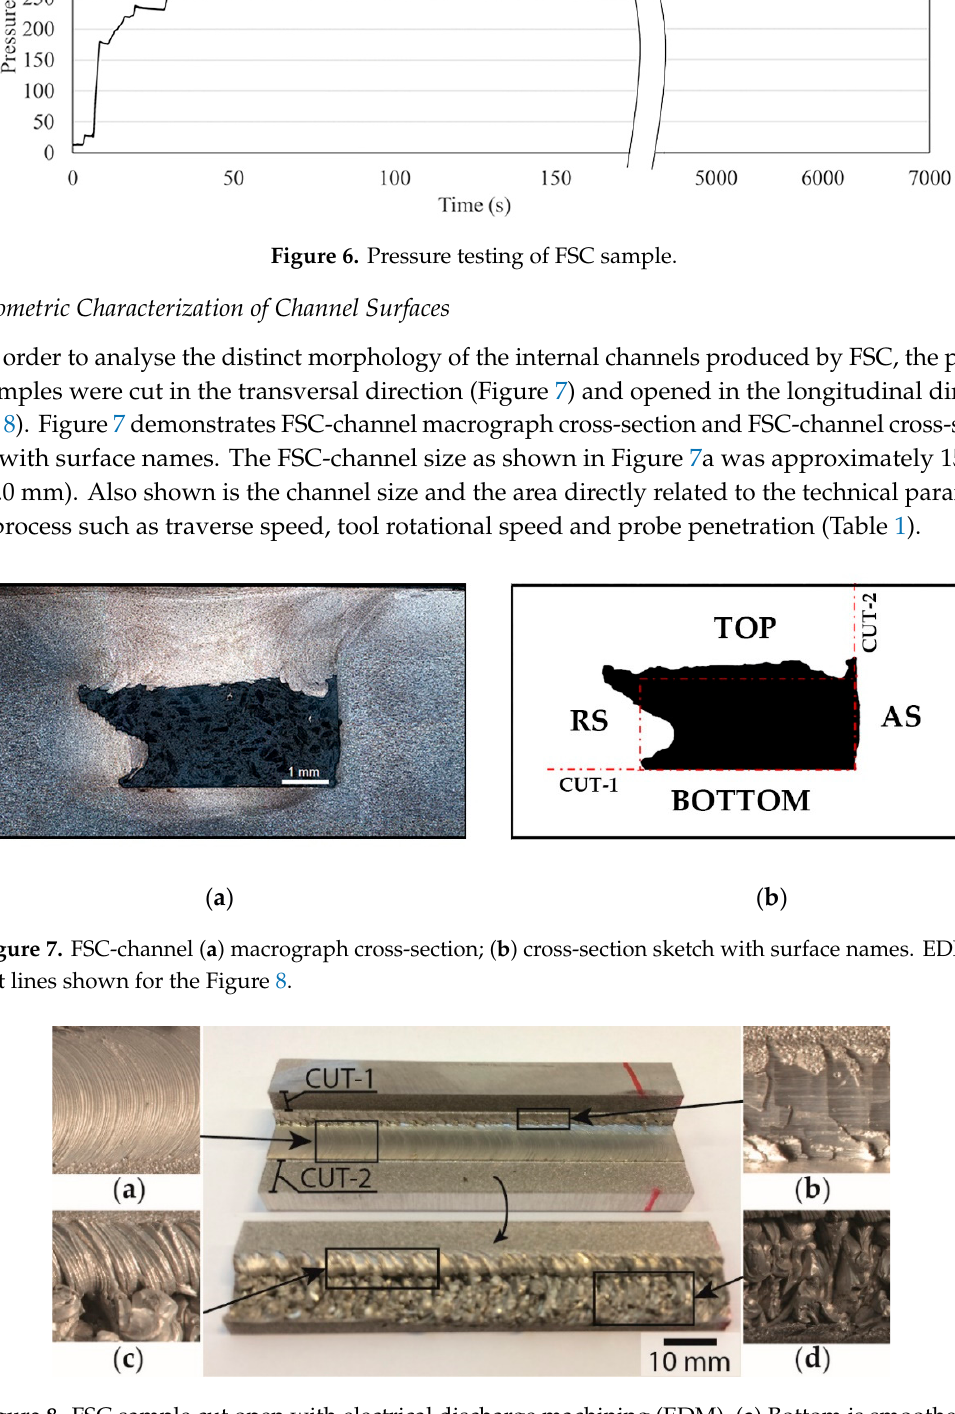
Figure 8. FSC sample cut open with electrical discharge machining (EDM). ( a ) Bottom is smoothest surface of the FSC-channel produced by the bottom surface of the probe tip; ( b ) the advancing or shear side, also quasi flat and rougher than the bottom; ( c ) the retreating or flow side, with a fairly rough and wavy profile along the channel depth; and ( d ) the top surface which is the roughest. EDM cut lines are illustrated in the Figure 7 cross-section. Adapted from